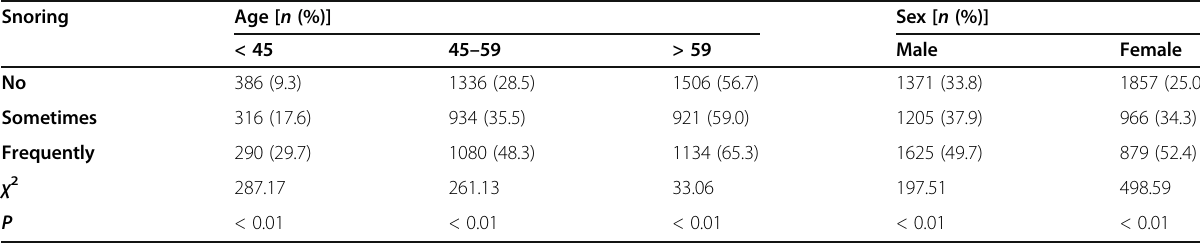
Table 2 Prevalence of hypertension among participants with different snoring frequency